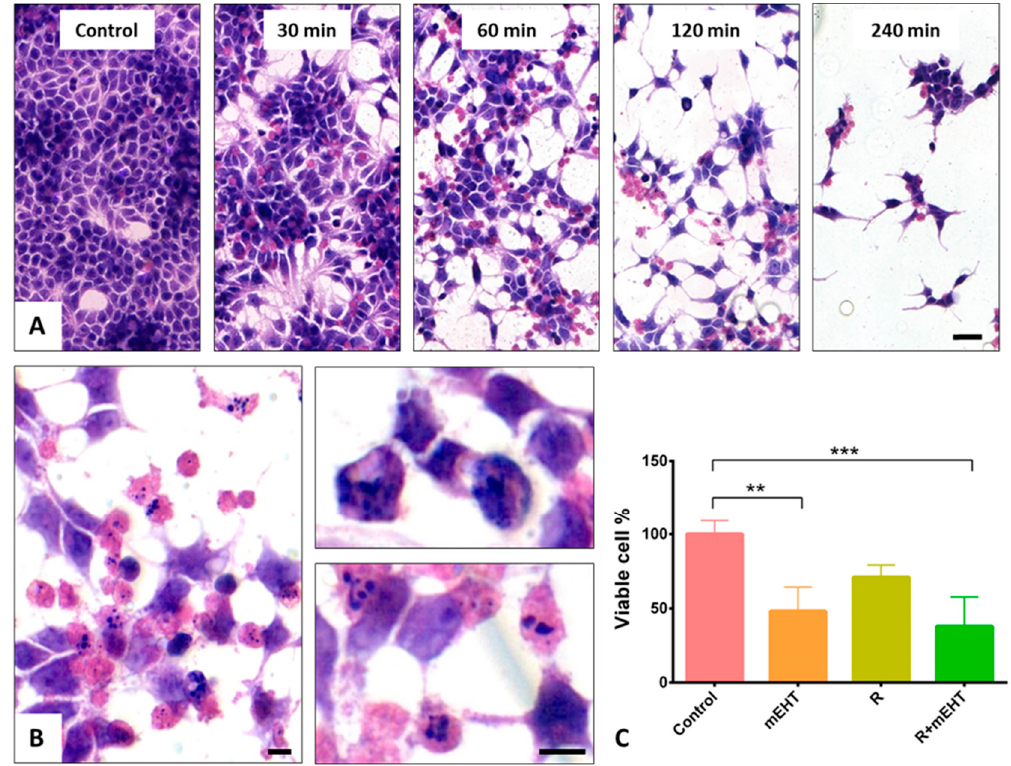
Figure 1. Hematoxylin and eosin staining of Panc1 cell cultures demonstrating cell loss and the major changes in cell morphology 24 h after different mEHT treatment durations ( A ). Scale bar: 40 µm. Higher magnifications reveal nuclear shrinkage, chromatin condensation (upper right) and apoptotic bodies (lower right) after 60 min treatment ( B ). Scale bars: 10 µm. Significant reduction in viable cell numbers, detected using trypan blue staining, both after 60 min mEHT monotherapy ( p = 0.014), and after combination of mEHT and 2 Gy radiation (R+mEHT) ( p = 0.0029) but not after radiotherapy alone (R). Kruskal–Wallis test reveals significant difference ( p = 0.0007) among the 4 groups ( C ). The asterisks mark the value of p : ** means p ≤ 0.01, *** means p ≤